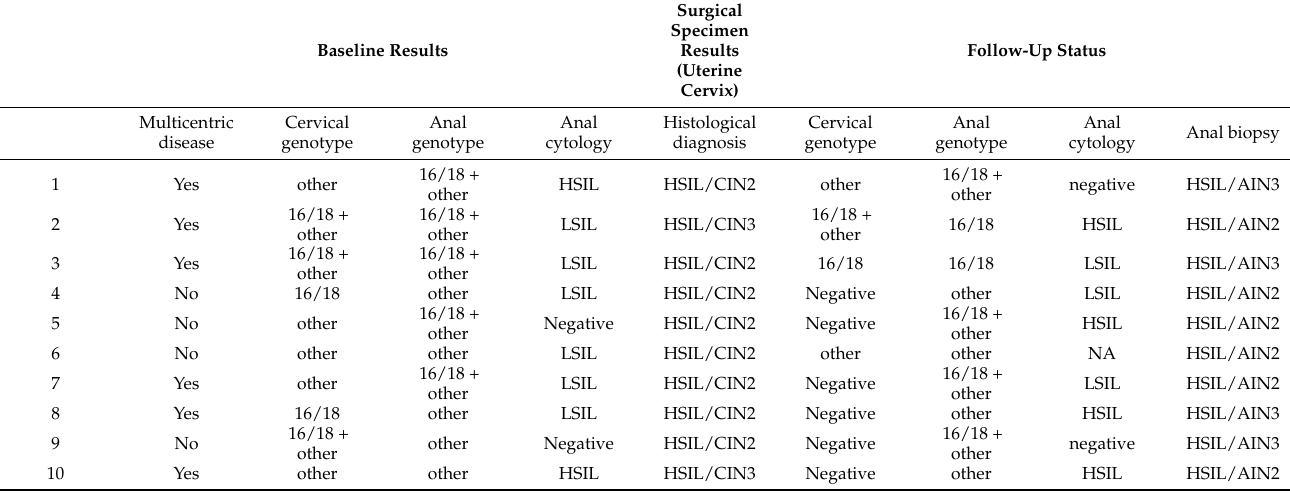
Table 5. Baseline and first follow-up control results of cervical and anal human papillomavirus (HPV) and lesions of the 10 women who developed high grade squamous intraepithelial neoplasia/anal intraepithelial lesion